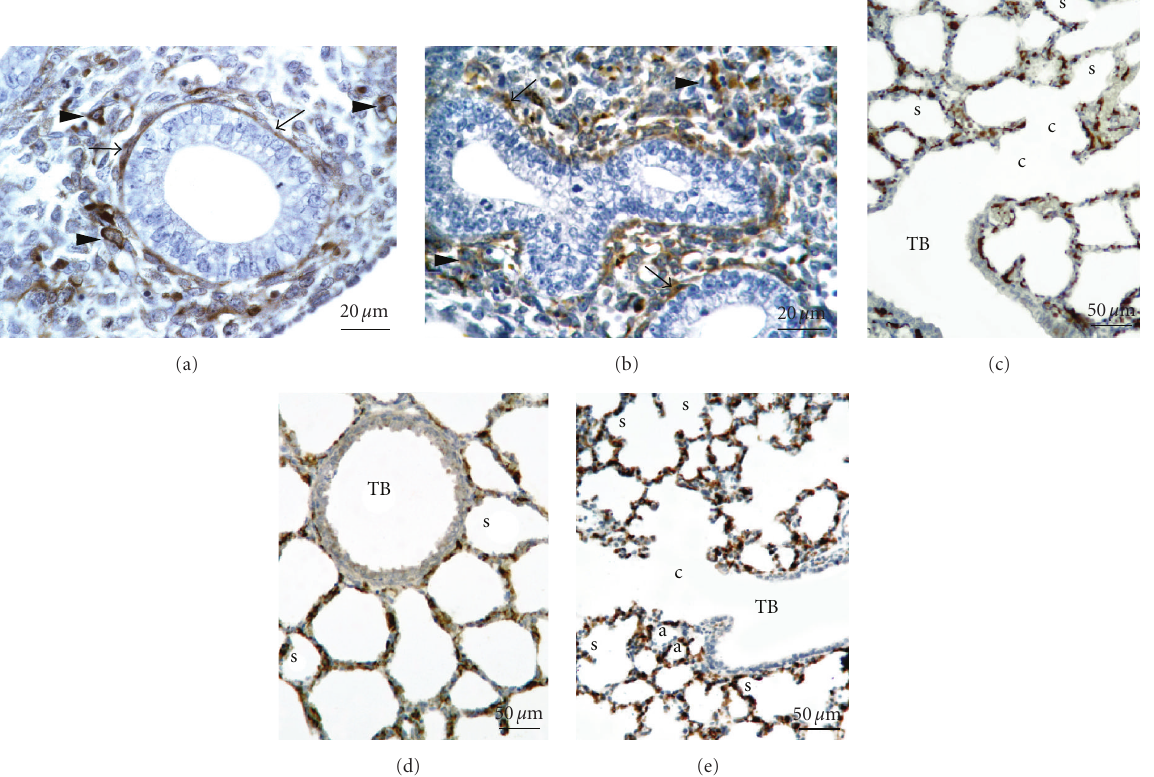
Figure 2: Rat lung. Bouin fixation. PDE5 immunohistochemistry carried out via the amplified ABC method on microwave treated sections. Haematoxylin counterstaining. (a) E15.5, (b) E17.5, (c) P3, (d) P7, (e) P14. s: saccule; a: alveolus; c: canalicular portion of the respiratory space; TB terminal bronchiole; LB larger bronchiole. ((a), (b)) Bar 20 μ m; ((c), (d), (e)) Bar 50 μ m. ((a), (b)) positivity is restricted to the cytoplasm of several cells, the majority of which are scattered in the stroma (arrowheads), while some are closely apposed to the respiratory tubule (arrows). The tubular epithelium is unlabelled. ((c), (d), (e)) labelling is restricted to the distal parenchyma, including sacculi, alveoli, and canalicular portions of respiratory spaces. The epithelium of terminal bronchioles is